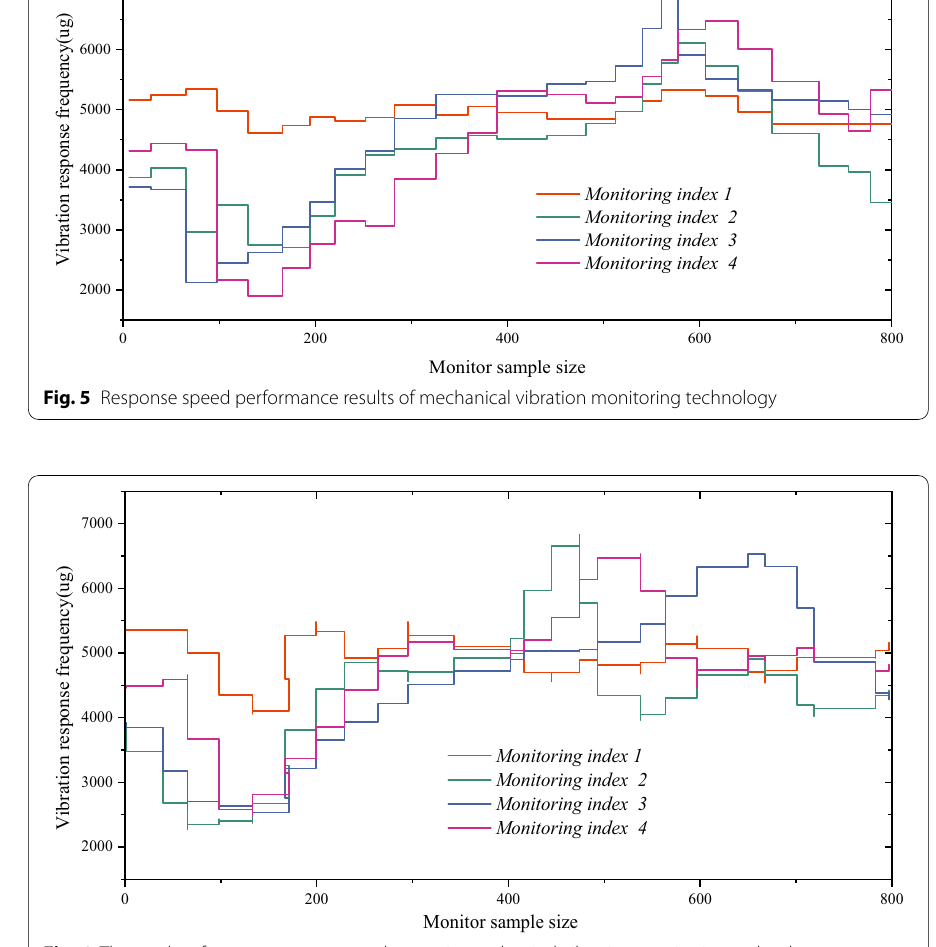
Fig. 6 The results of server concurrency tolerance in mechanical vibration monitoring